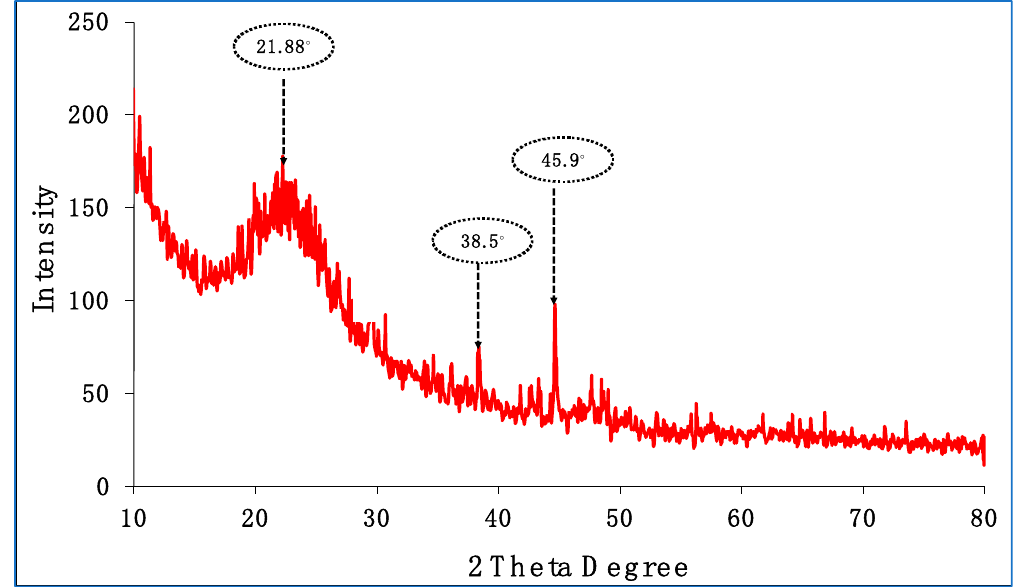
Figure 2. SEM of SiO 2 -NPs at different magnifications ( A ) 13 kx, ( B ) 24 kx.